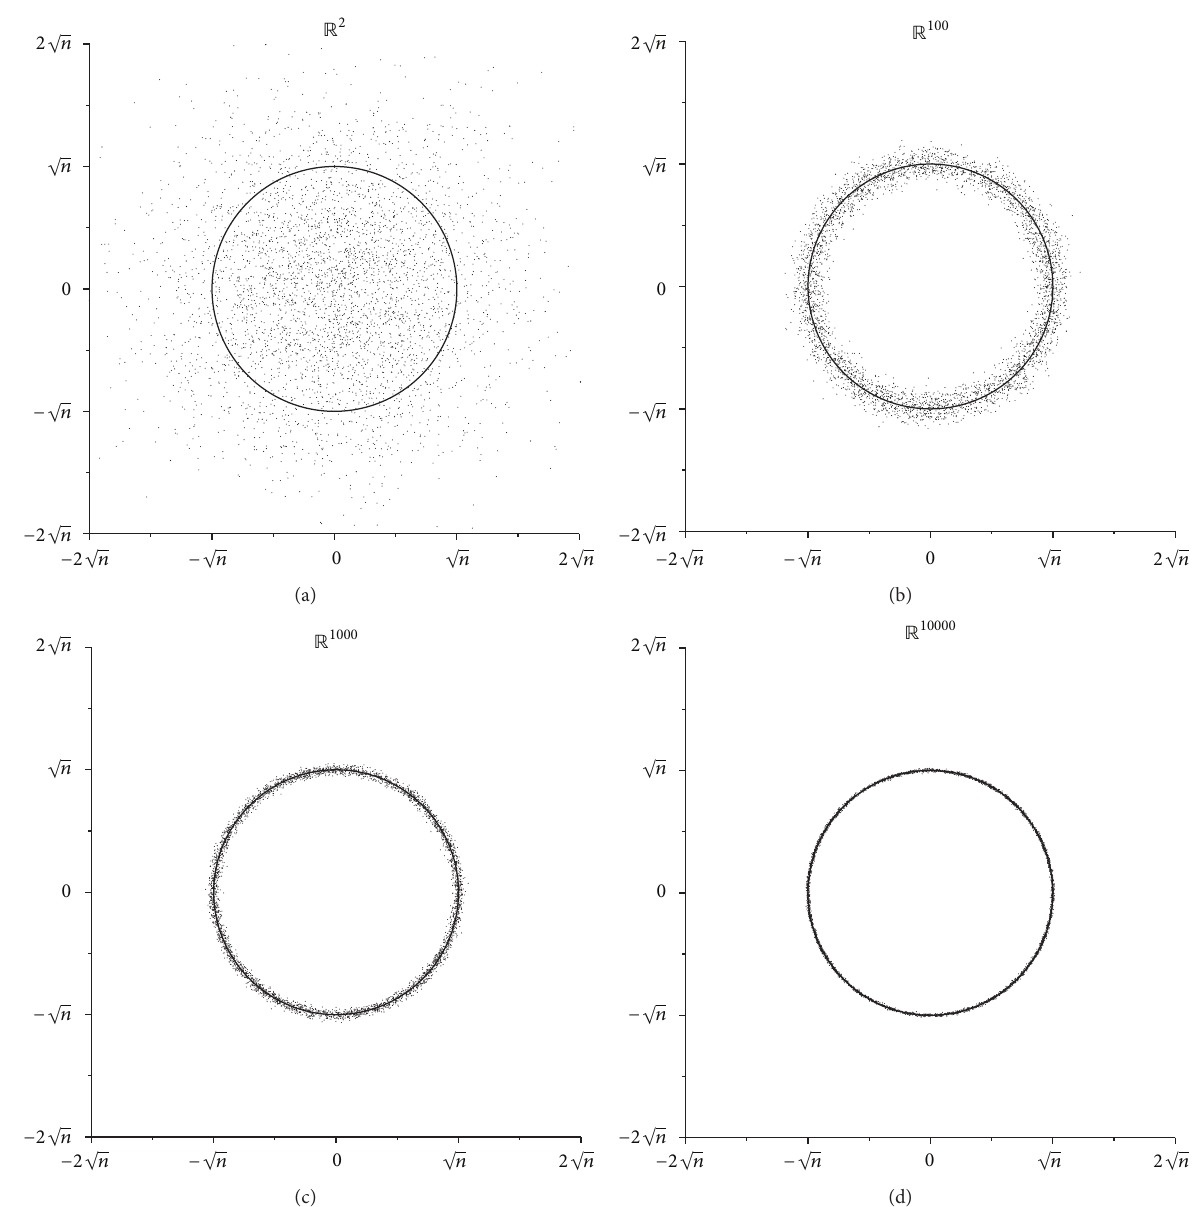
Figure 2: Schematic view of the concentration of 𝑁 𝑒 = 6400 samples of a normal law N (0, I ) toward a spherical shell of radius √𝑛 and thickness 1/√2 as the dimension increases from 𝑛 = 2 (a) to 𝑛 = 100 (b), 𝑛 = 1000 (c), and 𝑛 = 10000 (d) (see text for the details of the